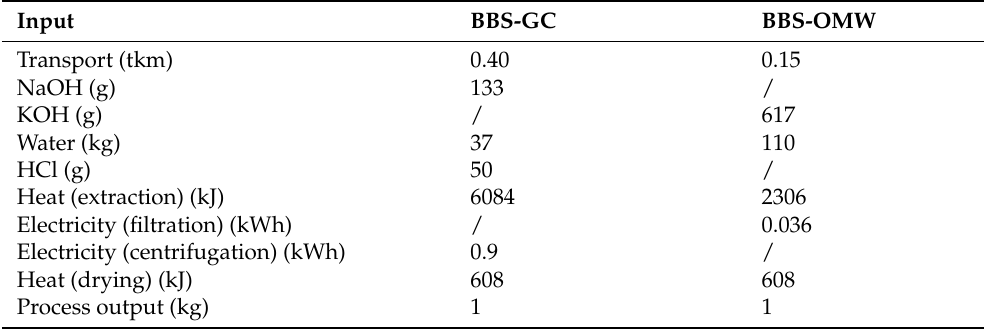
Table 2. Inventory data for the isolation processes of 1 kg of BBS from different sources (GC: green compost; OMW: oil mill waste). Input BBS-GC BBS-OMW Transport (tkm) 0.40 0.15 NaOH (g) 133 / KOH (g) / 617 Water (kg) 37 110 HCl (g) 50 / Heat (extraction) (kJ) 6084 2306 Electricity (filtration) (kWh) / 0.036 Electricity (centrifugation) (kWh) 0.9 / Heat (drying) (kJ) 608 608 Process output (kg) 1 1